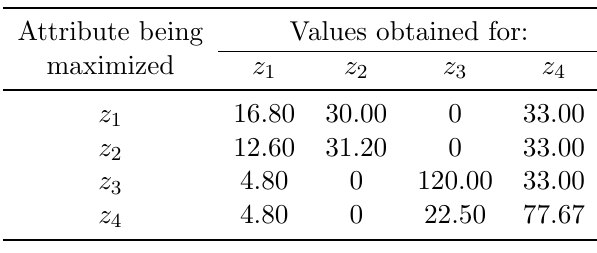
Table 1: Payoff table for the game reserve